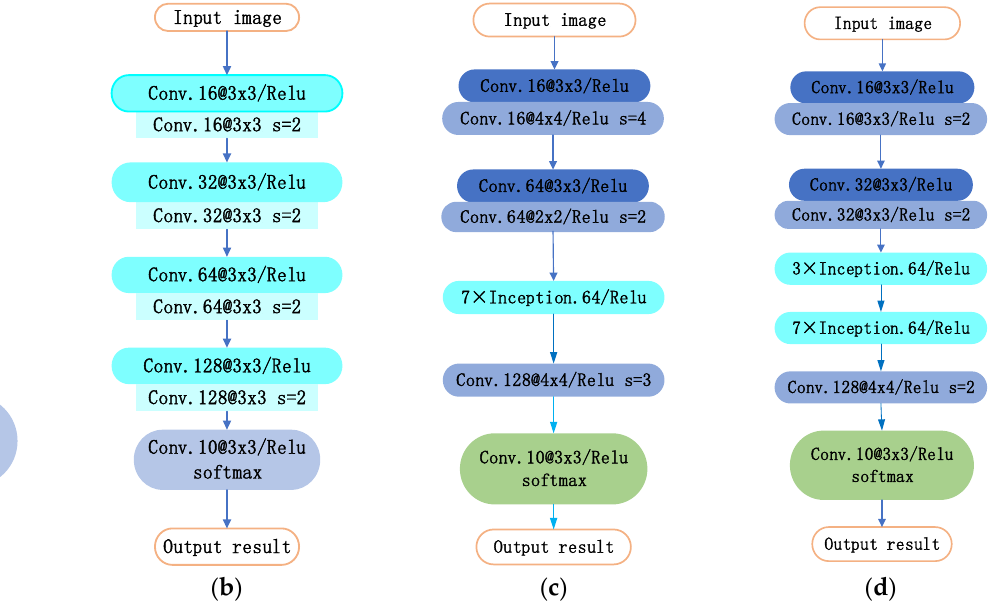
Figure 8. Network structure: ( a ) CNN; ( b ) IFCNN; ( c ) IFCNN1; ( d ) IFCNN2. In order to verify the performance of the proposed method, the Moving and Stationary Target Acquisition and Recognition (MSTAR) dataset is utilized for experiments. Select the ten-target samples at 15° and 17° depression angles from the MSTAR dataset. The 10 classes of targets on the MSTAR dataset are BMP2, BRDM2, 2S1, BTR60, BTR70, D7, T62, T72, ZIL131, and ZSU234. The samples at a depression angle of 17° are utilized for training, and the samples at a depression angle of 15° are utilized for testing.